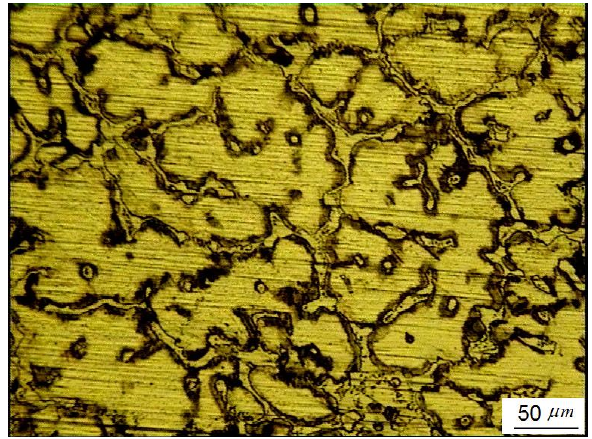
Figure 10: Optical microscope image of as-cast AZ30 after casting at room temperature.